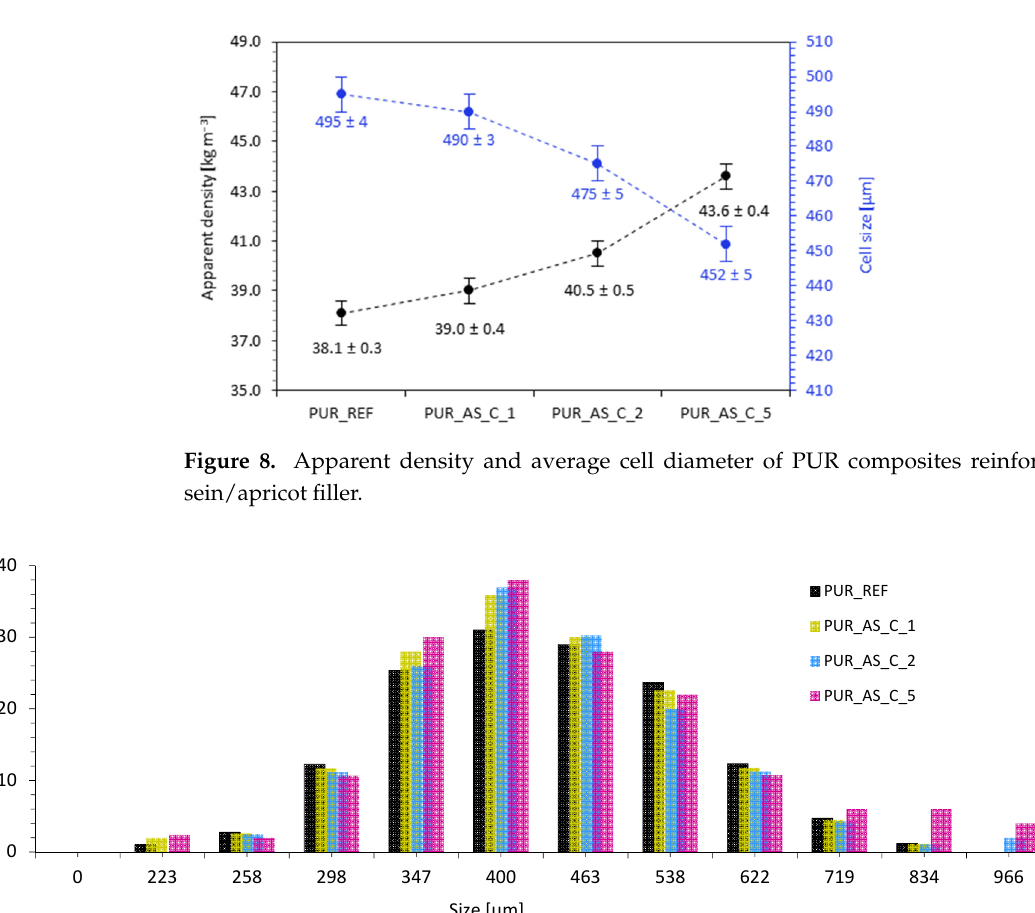
Figure 7. Cellular morphology of PUR composites: ( a , b ) PUR_REF; ( c , d ) PUR_AS_C_1; ( e , f ) PUR_AS_C_2; ( g , h ) PUR_AS_C_5.